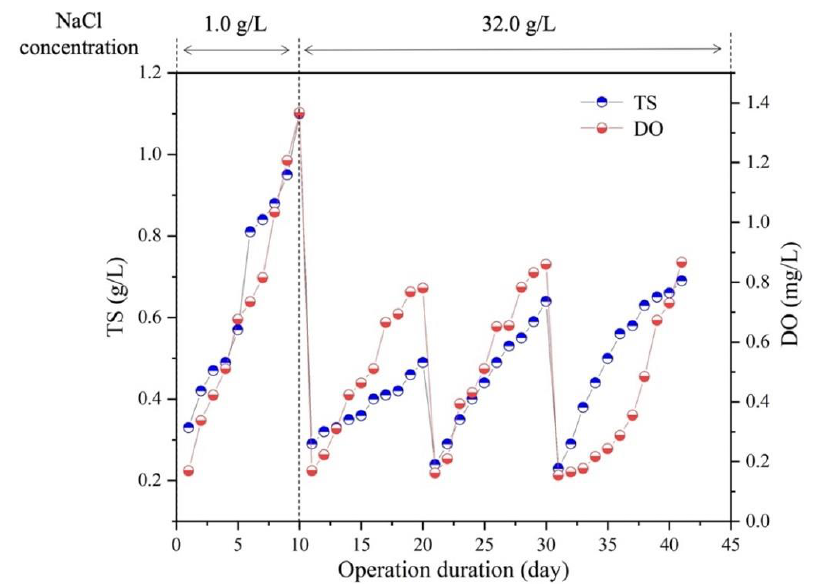
Figure 1. Performance of microalgal growth and oxygen production in synthetic mariculture wastewater. All experiments were operated under a 12/12 h light/dark cycle and illumination of 80 μmol/m 2 /s at 25 °C.